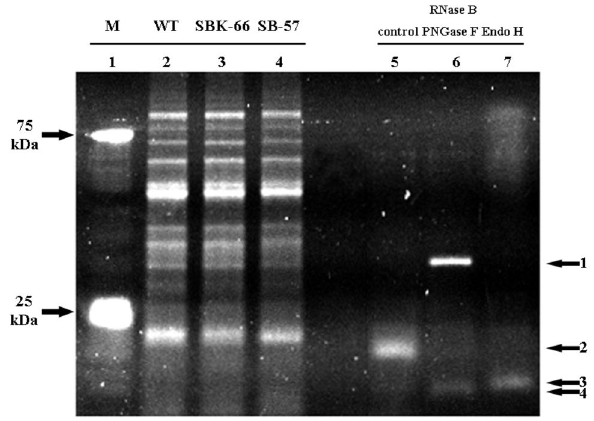
Figure 7. Glycoprotein staining of transgenic lines and WT line in rice seeds. Total protein was extracted from mature dehulled seeds of SB-57 and SBK-66 transgenic lines and WT. RNase B was used as the glycoprotein control. To evaluate endoglycosidase digestion efficiency, RNase B was digested by PNGase F and Endo H. Lane 1: marker; lane 2: WT; lane 3: SBK-66; lane 4: SK-57; lane 5: RNase B control without digestion; lane 6: RNase B digested by PNGase F; and lane 7: RNase B digested by Endo H. Band 1: PNGase F; band 2: RNase B; band 3: RNase B with Endo H digestion, and band 4: RNase B with PNGase F digestion.